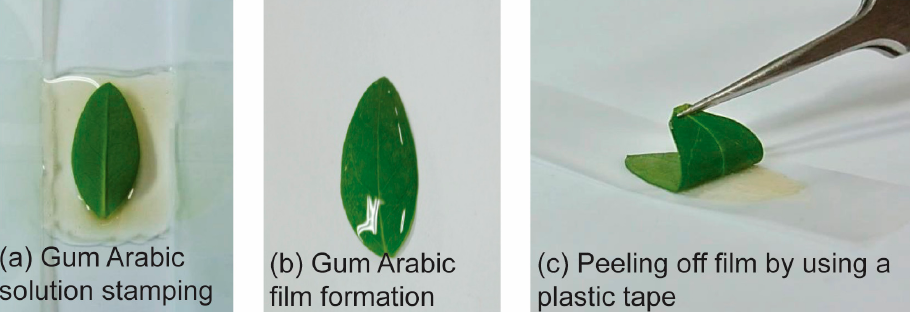
Figure 6. Mechanical peeling of a surface layer of a leaf by utilizing polymeric gum Arabic films. See Section 3 for the detailed